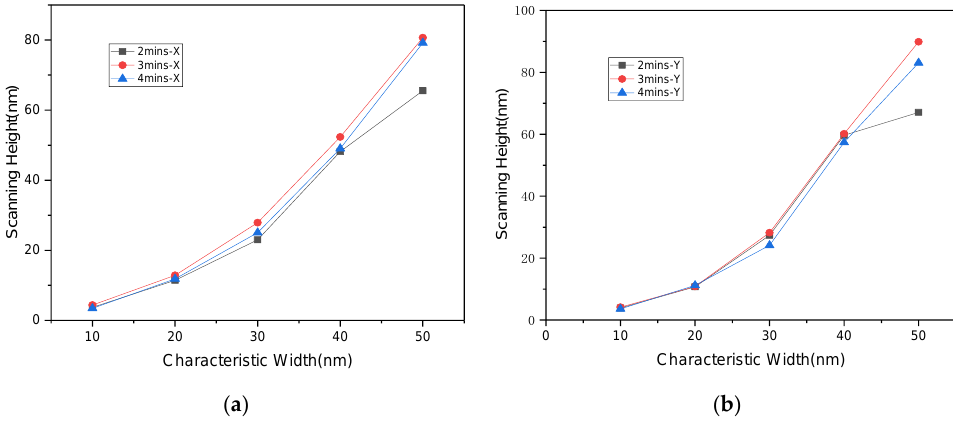
Figure 12. Information corresponding to the depth and width of the tip based on tip characterizers of different etching time: ( a ) along X direction; ( b ) along Y direction.